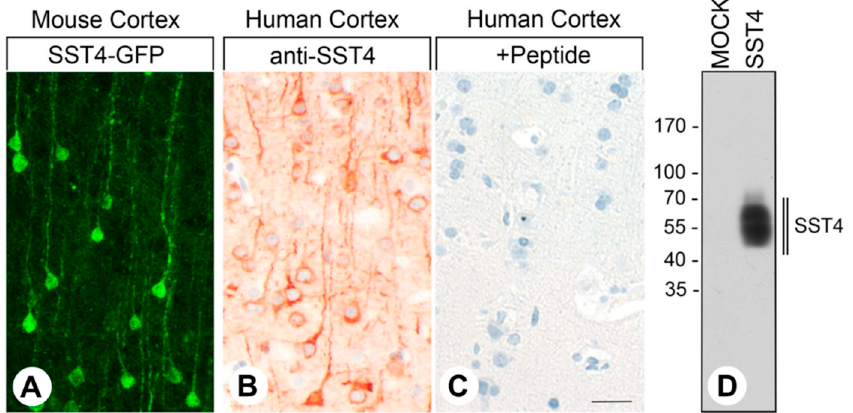
Figure 3. Evidence of SST4 expression in SST4-eGFP knockin mice. SST4 was detected immunohistochemically in tissue sections from SST4-eGFP knockin mice using a commercial rabbit anti-eGFP antibody (ab290, Abcam, Cambridge, UK; 1:1000). Scale bar: ( A – E ) = 60 µm; ( F ) = 100 µm.